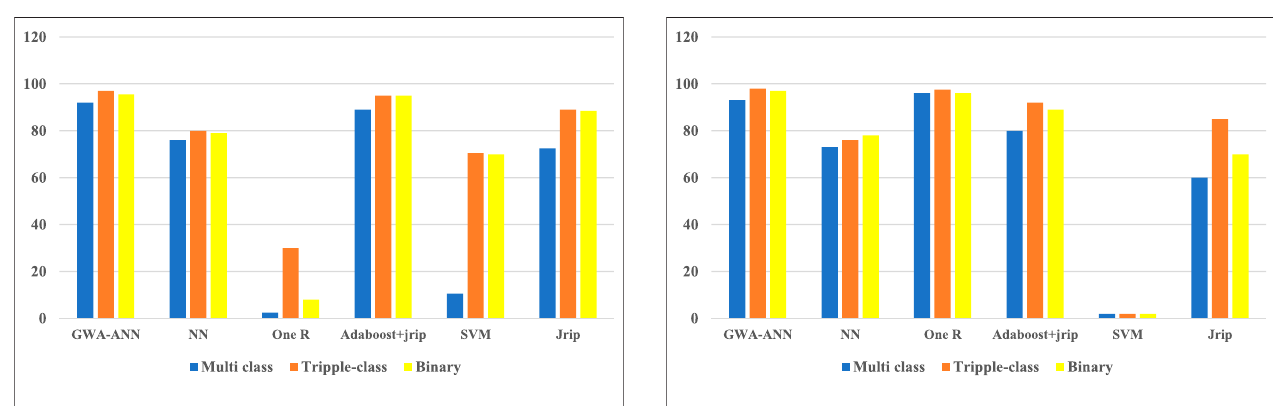
FIGURE 12 | Mean precision amounts of diverse classi fi ers of the 45 datasets.